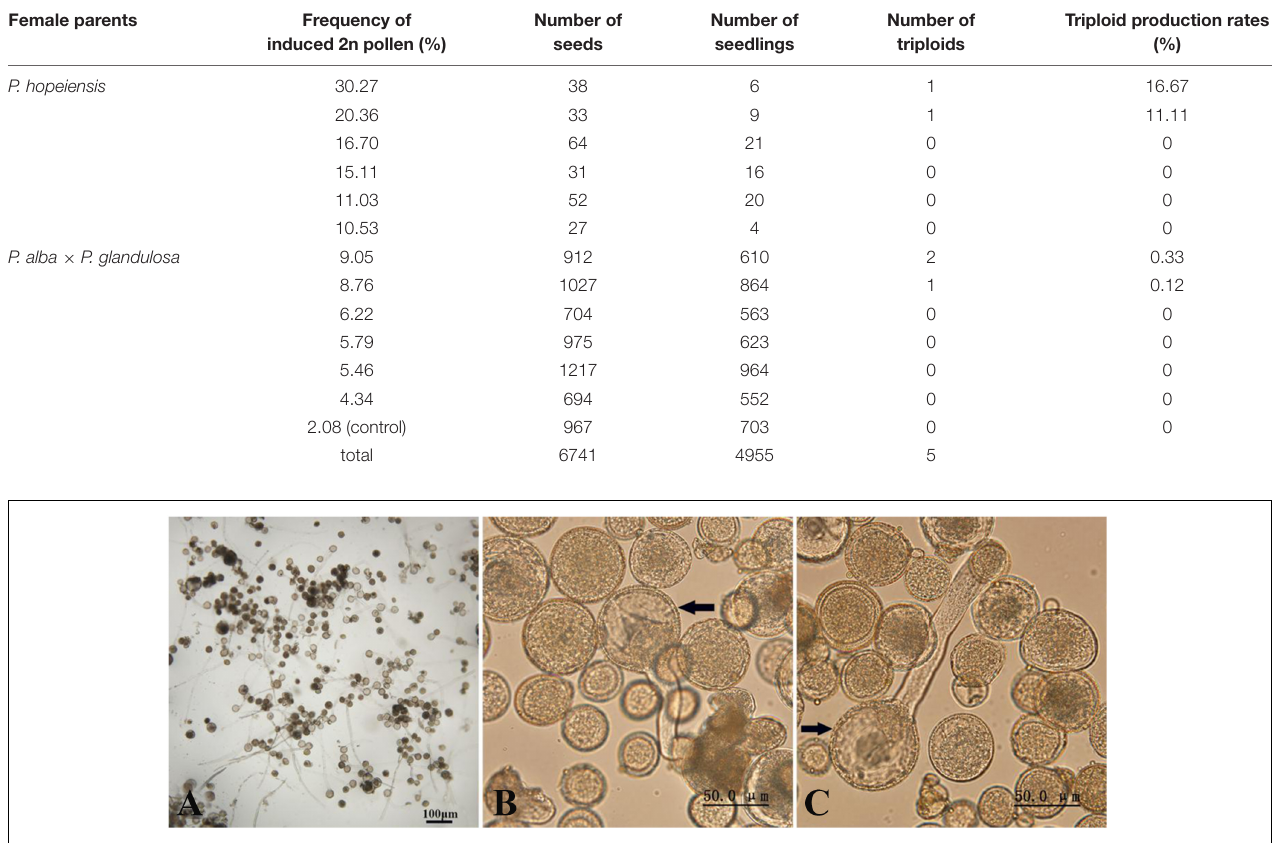
FIGURE 4 | Fresh colchicine-induced pollen of P. canescens derived from the treatment given 11 injection times germinated on media. (A) Germinated fresh colchicine-induced pollen derived from the treatment given 11 injection times. (B) Germinated 2n pollen induced by colchicine (arrow). (C) Germinated natural 2n pollen (arrow). Scale bar = 100.0 (A) and 50.0 µ m (B,C) .